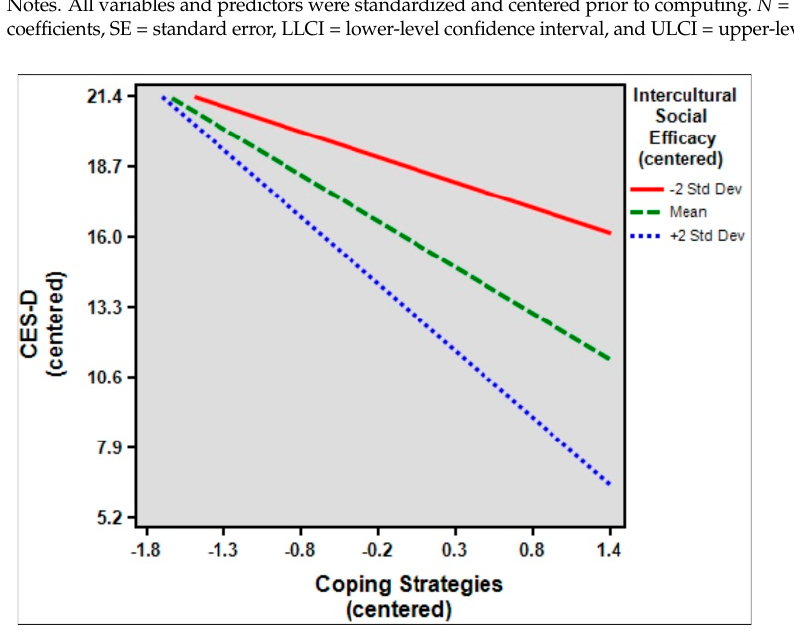
Figure 2. Simple slope plot for the moderation effect of